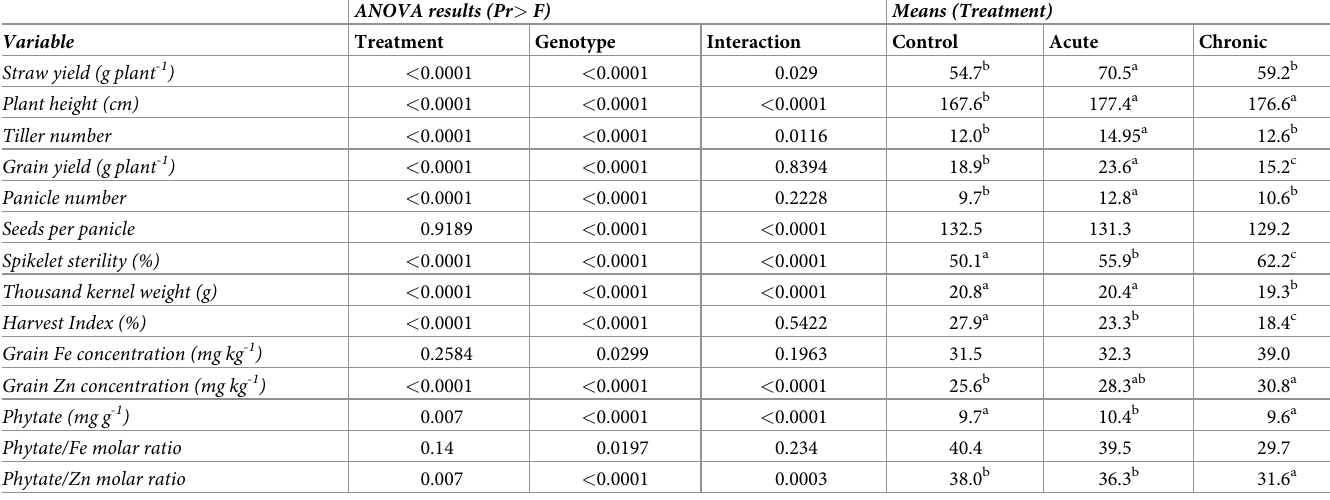
Table 3. ANOVA results and treatment mean values for yield and grain quality traits of wild and domesticated rice species exposed to acute or chronic iron